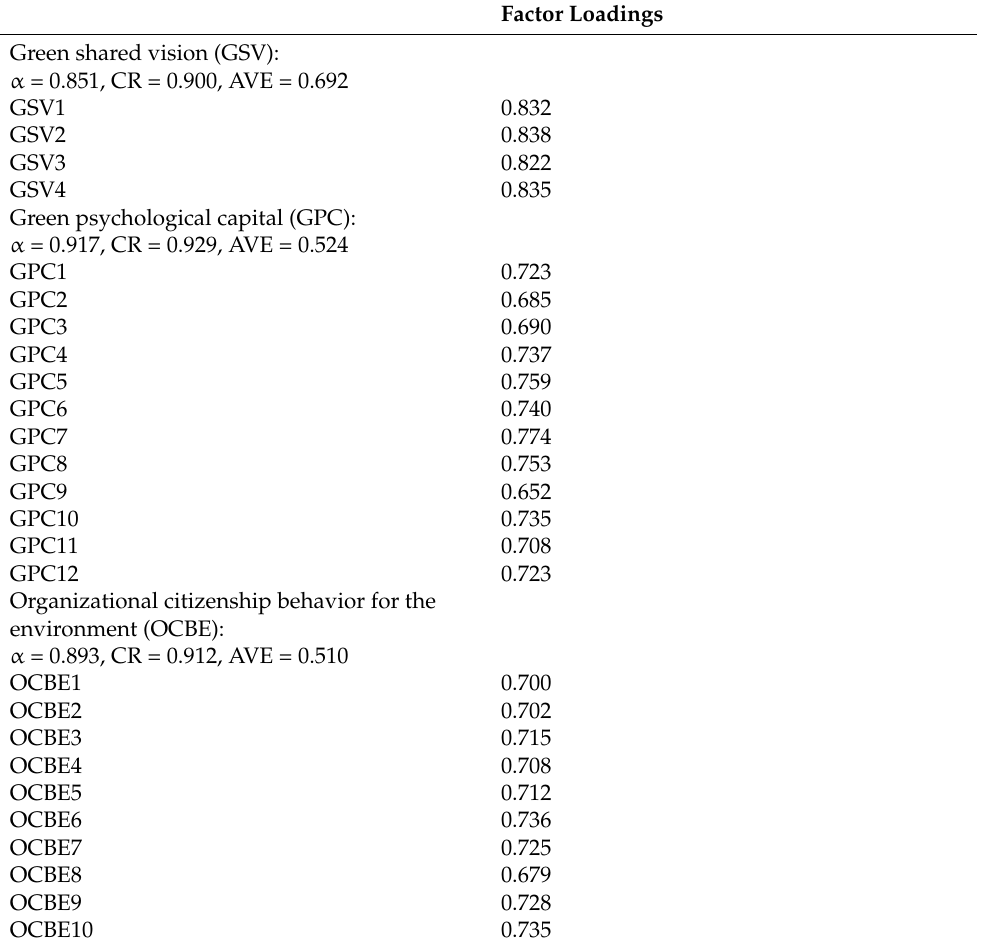
Table 3. Item loadings, Cronbach’s alpha, CR, and AVE of three factors.